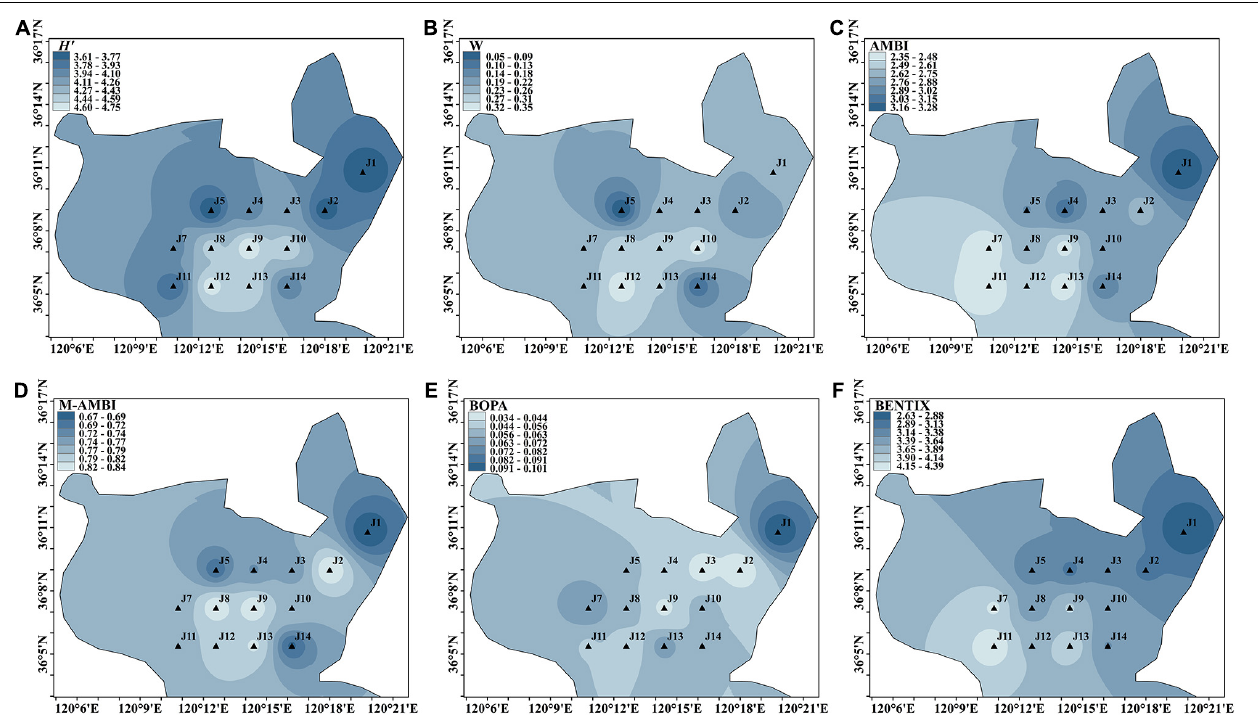
FIGURE 5 | Spatial distribution of environmental assessment in autumn cruise in Jiaozhou Bay, H (cid:48) (A) , W (B) , AMBI (C) , M-AMBI (D) , BOPA (E) , and BENTIX (F)